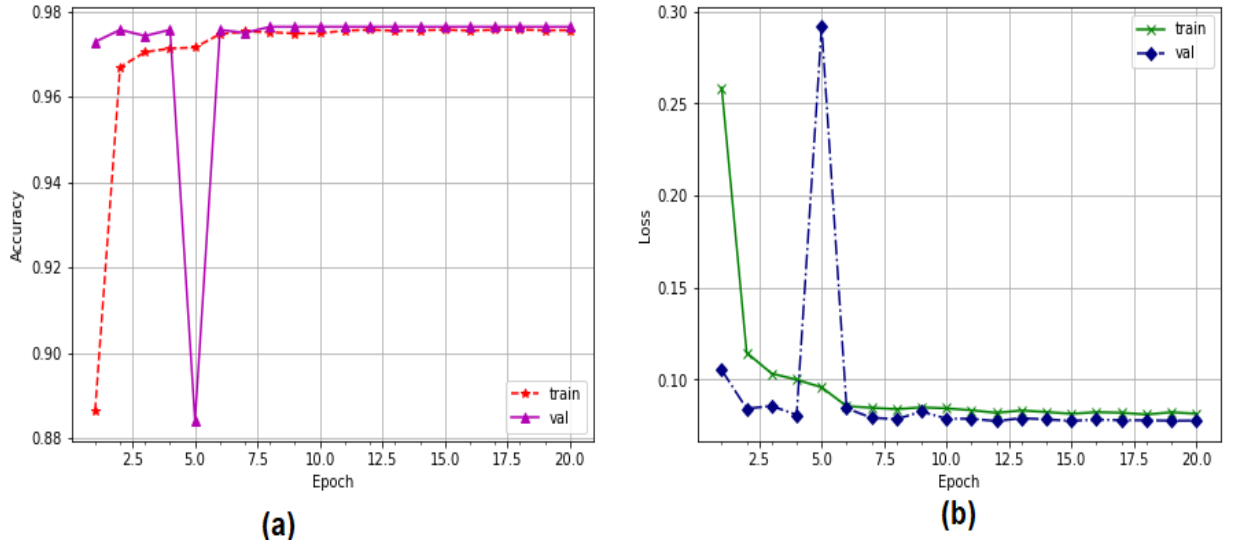
Figure 12. Performance of the CNN-LSTM model for detecting ICS attacks using the multiclass classification dataset: ( a ) Accuracy; ( b ) loss.